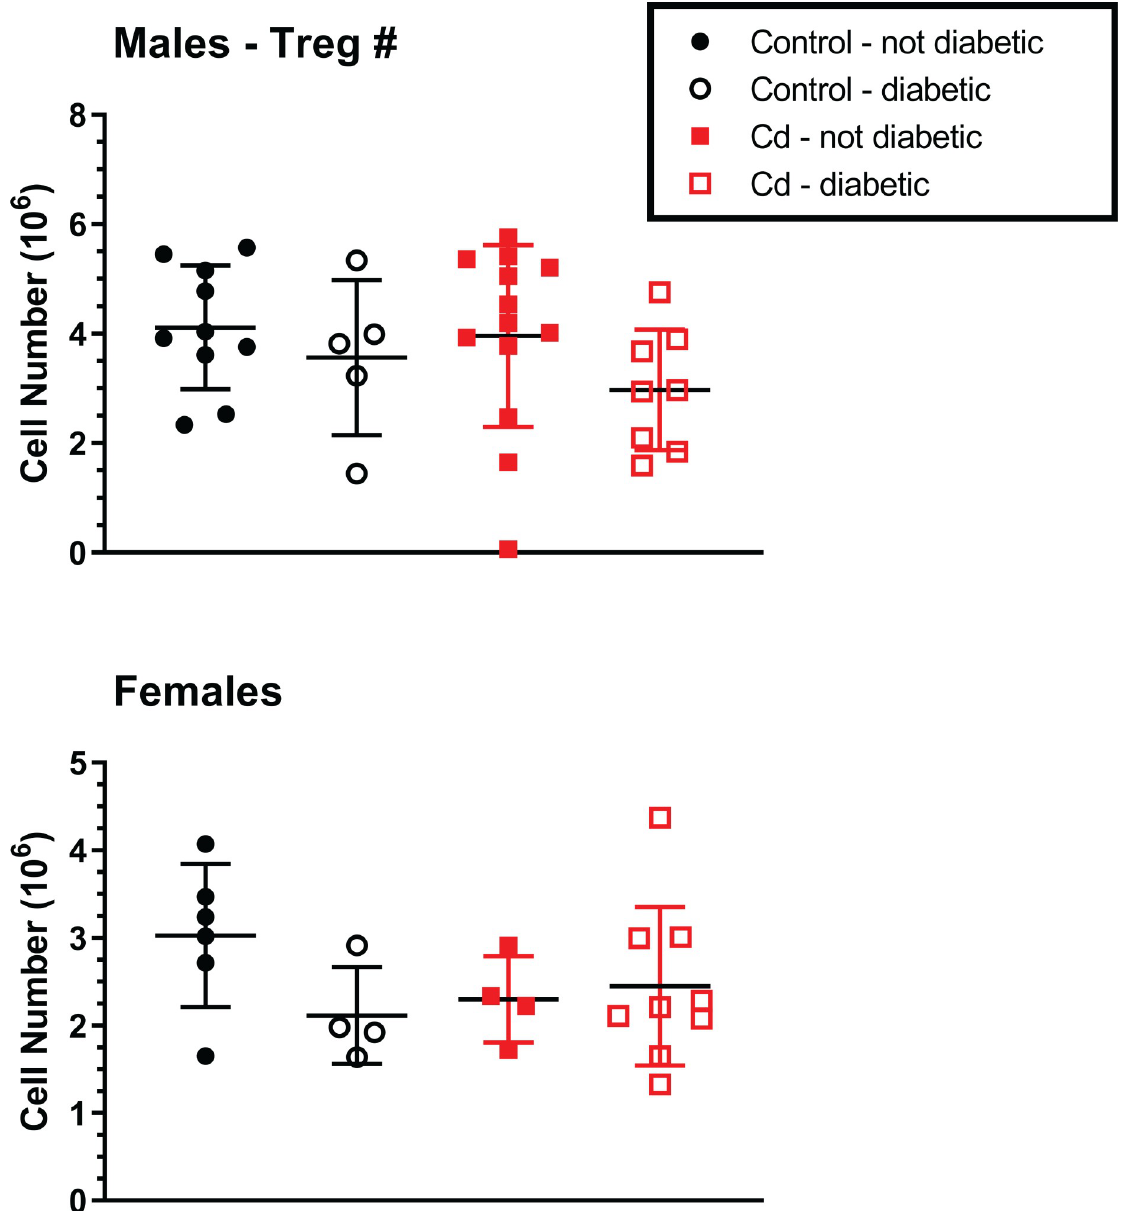
Fig 3. Analysis for Treg spleen cells of Cd-exposed NOD offspring. At 18 weeks (females) and 22 weeks (males), the spleens of the offspring were ablated and processed for flow cytometric analysis. CD4 + CD25 + FOXP3 + were quantified. Data are shown as mean ± SD. Males N = 5–13; Females N =